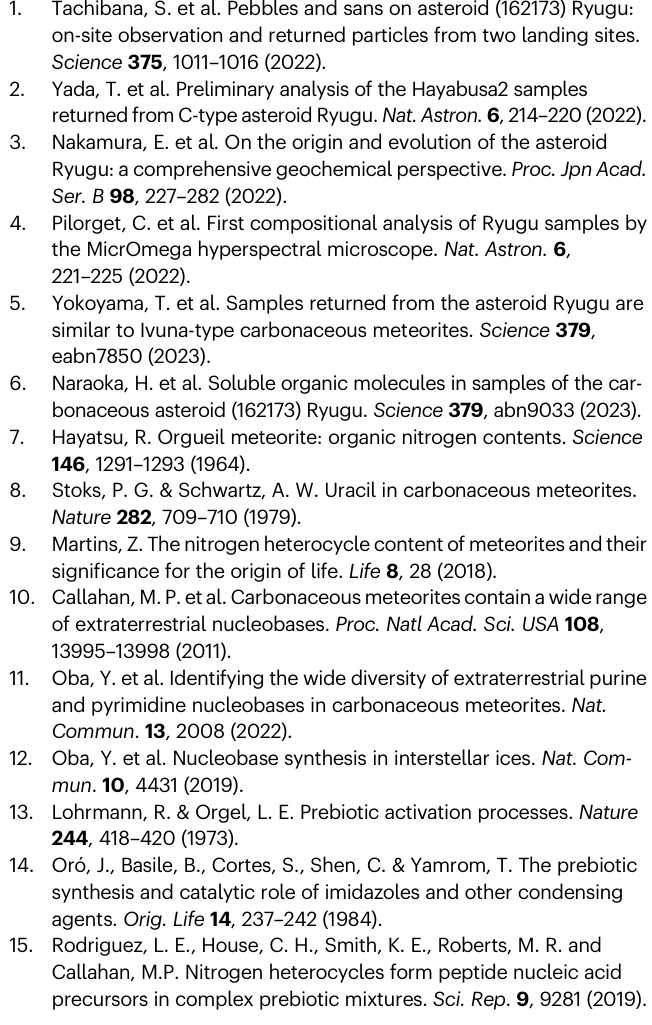
Fig. 8 | Conceptual view of surface and sub-surface physico-chemical features alongwithregolithdepth. Conceptualdiagramoftheeffectsofthermalcyclingin thediurnal(i.e.,variationindaytimeandnighttimeformax.andmin.temperatures; ~100°C) 4 and seasonal illumination cycles, which are constant exposure processes by photon and cosmic ray irradiation on the surface and subsurface regolith at Ryugu. The purple and orange arrows indicate ultraviolet and cosmic rays,